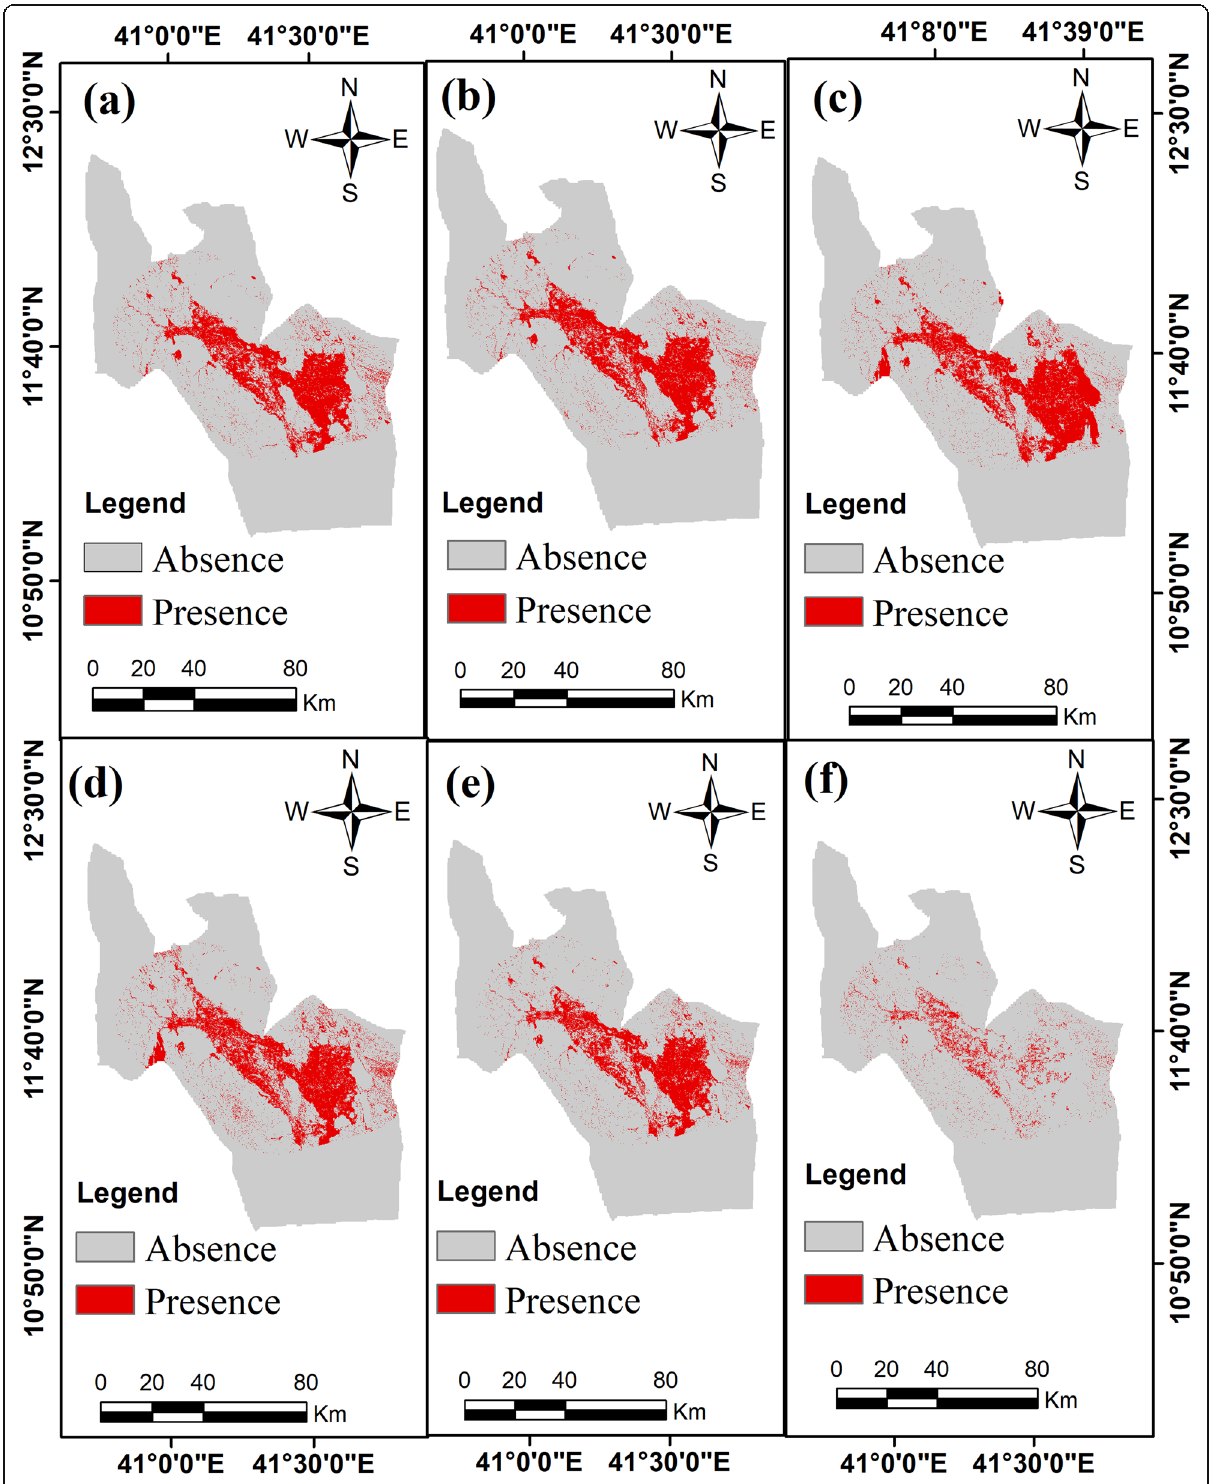
Fig. 4 Prosopis distribution maps using different SDMs: a Random Forest, b Boosted Regression Trees, c Support Vector Machine, d Generalized Additive Model, e Generalized Linear Model, and f